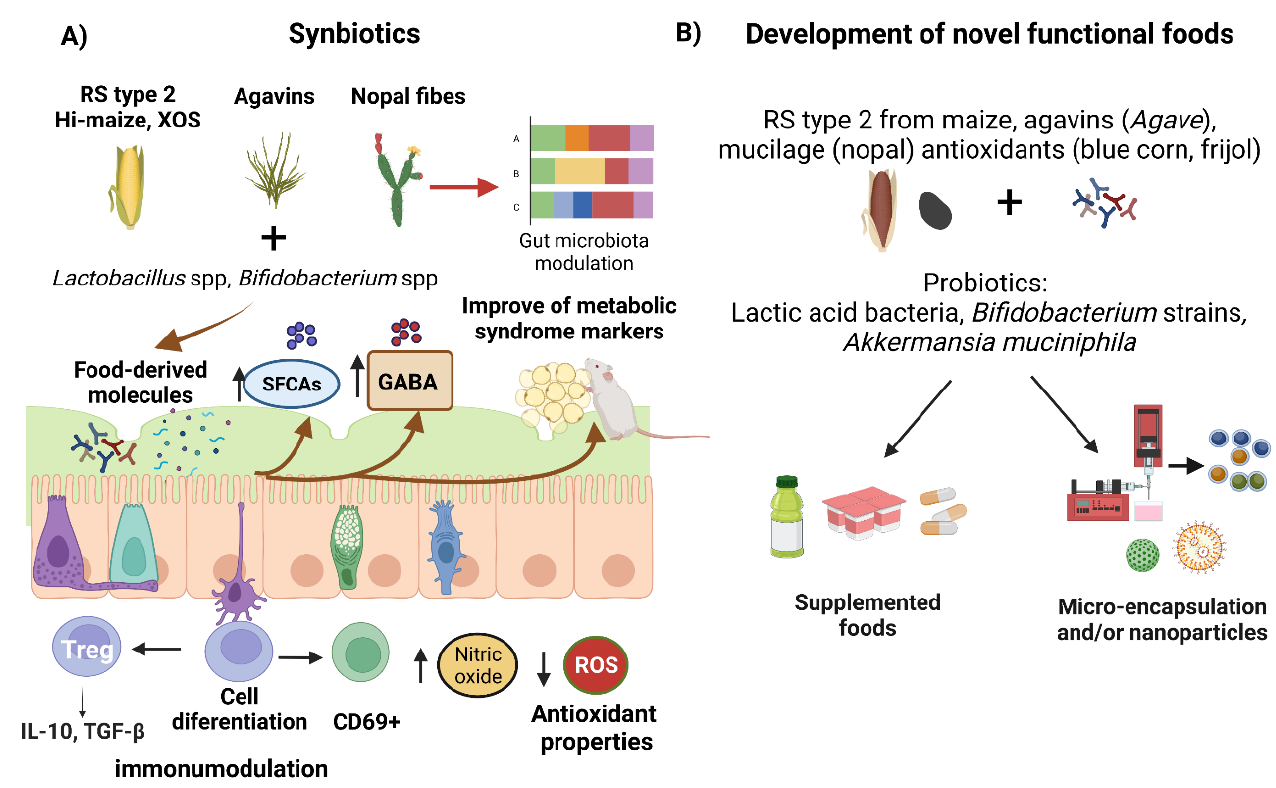
Figure 2. Mexican traditional food as a source of synbiotics for developing novel functional food products: ( A ) Prebiotic fibers in combination with probiotic strains could improve the release of food-derived compounds (as short chain fatty acids (SCFAs), or γ -aminobutyric acid (GABA)) and exert positive effects on intestinal and systemic health (i.e., immunomodulatory and antioxidant properties). ( B ) The selection of appropriate prebiotic and probiotic pairs for developing novel func- tional products. Traditional food supplements and the use of encapsulation and/or nanotechnology for the preservation and performance of synbiotics. Created by BioRender.com (2022) (accessed on 6 March, 2022).